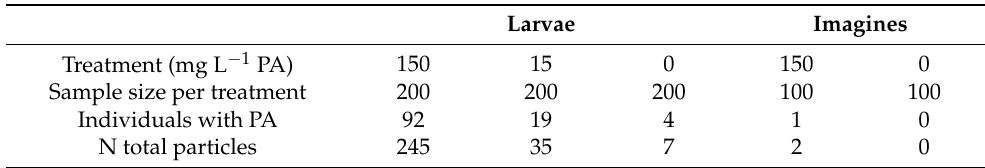
Table 1. Detection of polyamide (PA) microparticles in larvae and imagines of Chaoborus sp. after exposure in freshwater